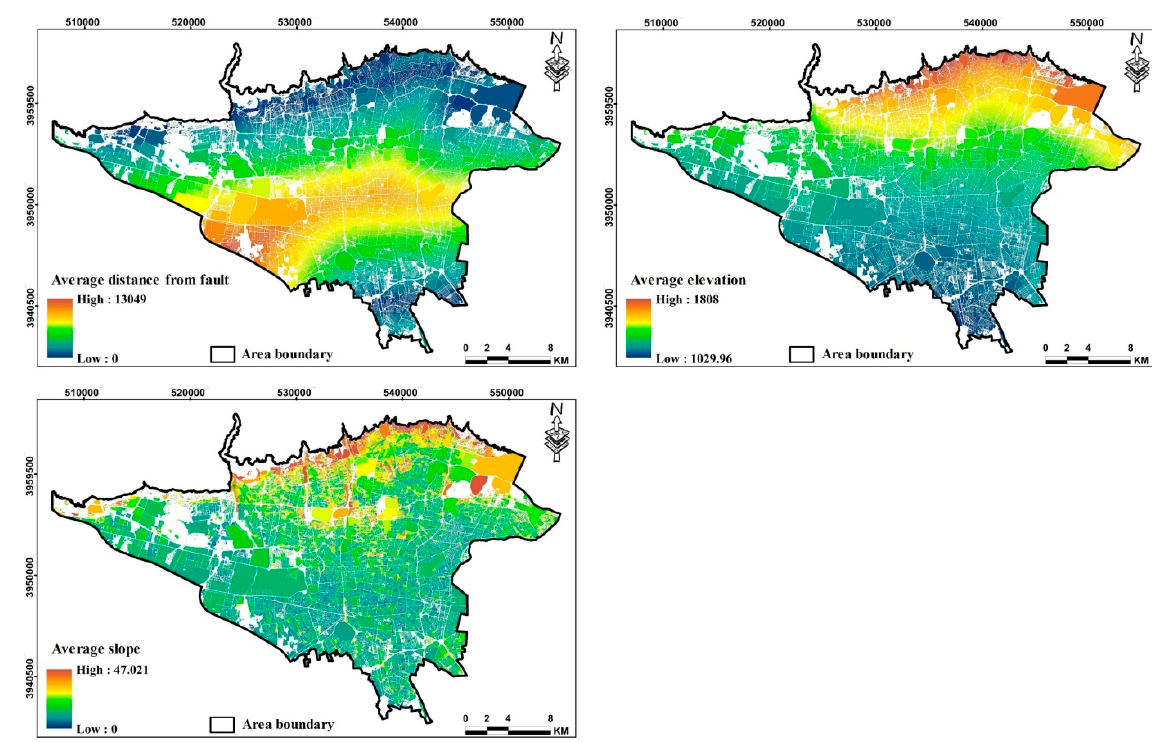
Figure 5. Map of exposure criteria.